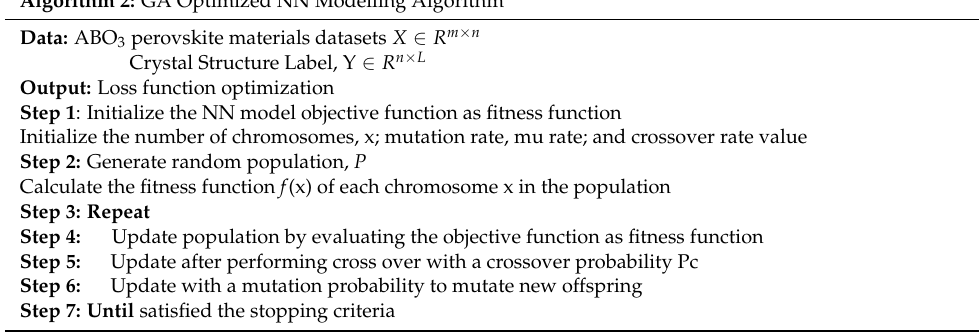
Algorithm 2: GA Optimized NN Modelling